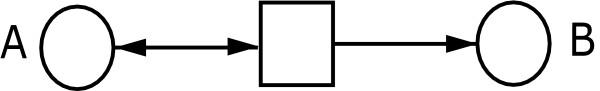
Case 1 using read arcs. Case 1 of using read arcs is represented. Precondition (substance) A does not lose its fulfilment (activity) by triggering the fulfilment (activation) of a condition (substance) B.